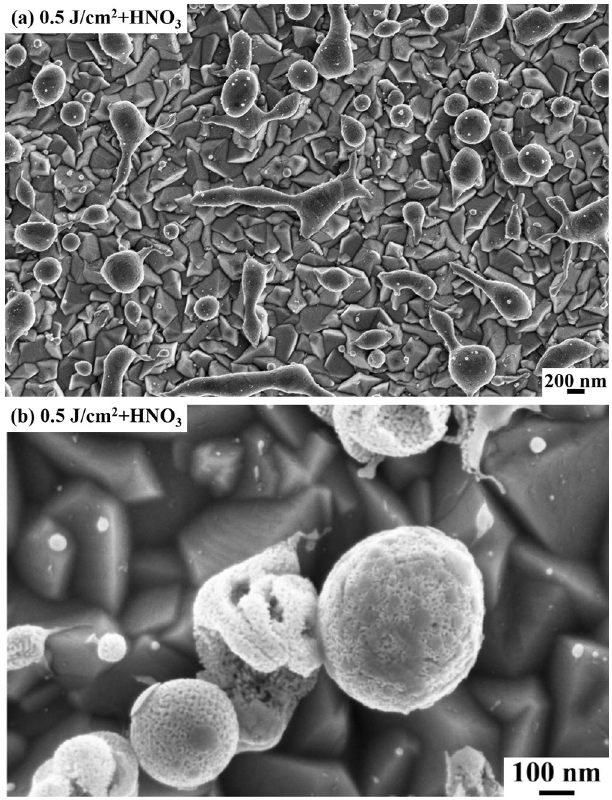
Figure 2. Representative SEM images [with increasing magnification from ( a ) to ( b )] of the nanoporous Au particles obtained by HNO 3 dealloying of the alloy Au–Ag particles obtained on the FTO surface after irradiating the Ag-Au bilayer by laser fluence 0.5 J/cm 2